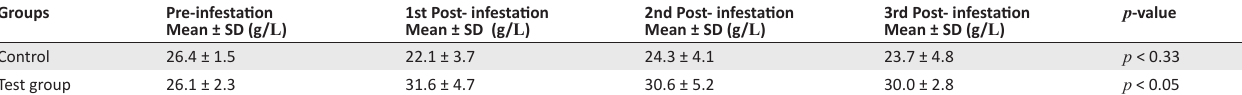
TABLE 3: Gamma globulin levels (g/ L ) in the serum of the test and control Saanen goats before and after three consecutive infestations of Rhipicephalus appendiculatus adult ticks. Groups